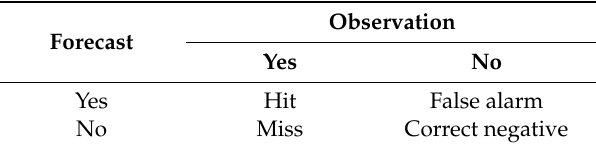
Table 3. Contingency matrix for systematic